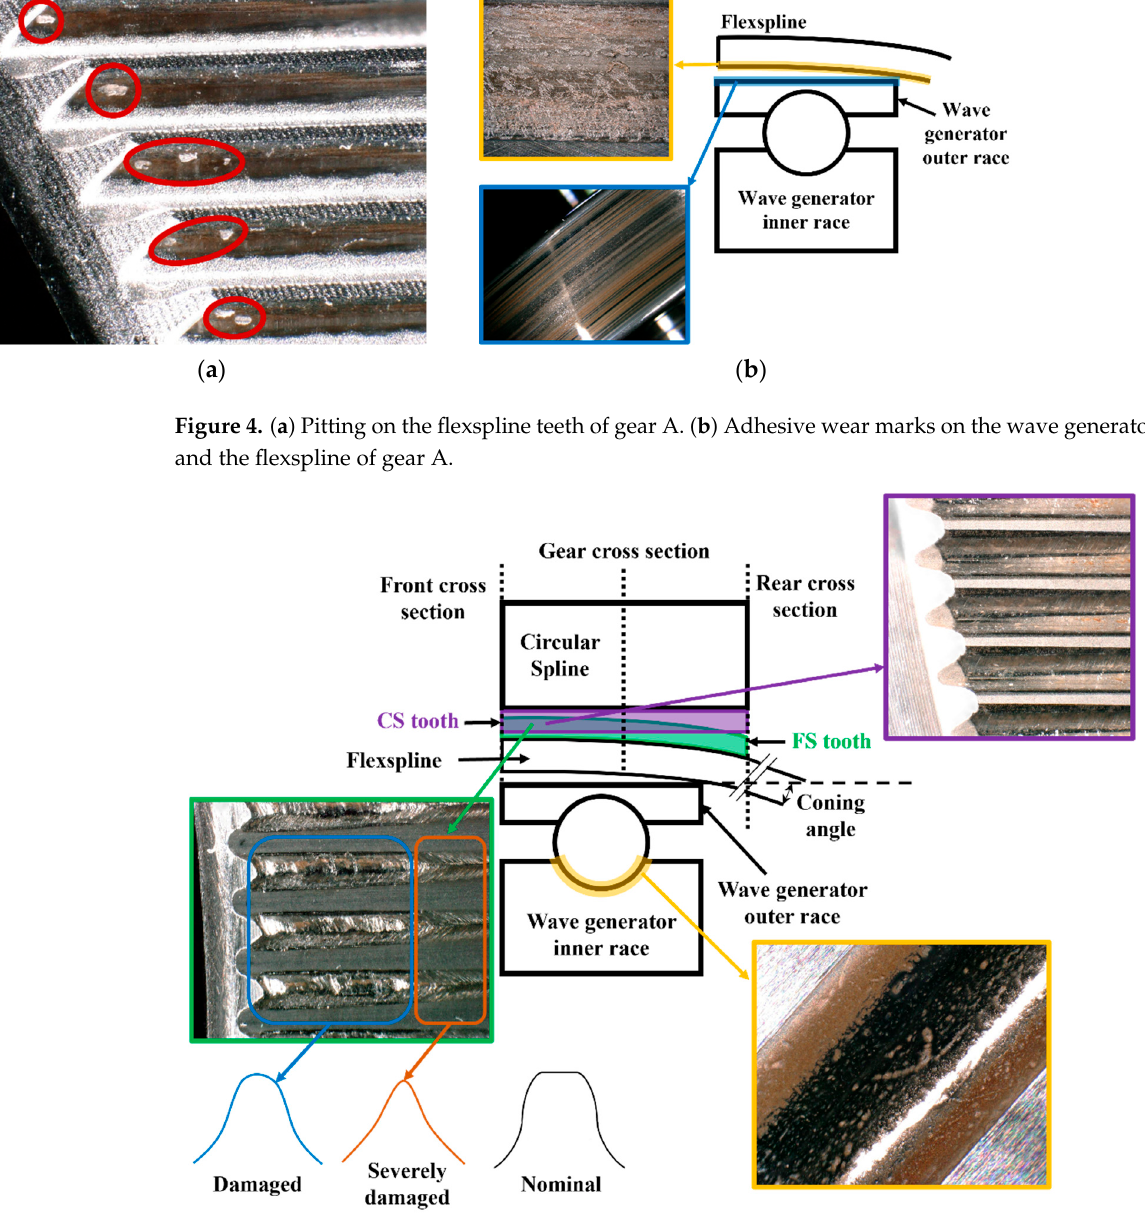
Figure 5. Effect of wear on the components of the strain wave gear B.